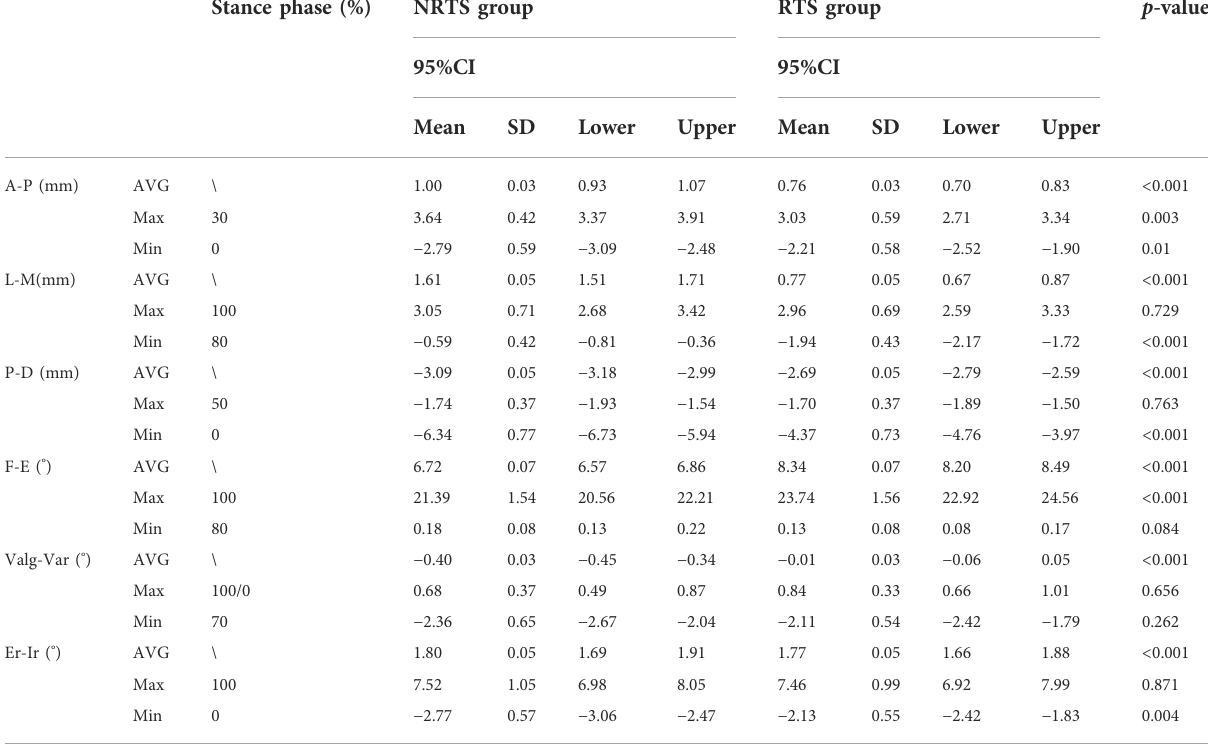
TABLE 2 Comparison of knee kinematics between those who passed the return-to-sports test and those who failed 9 months after ACL reconstruction. a Themaximumvalgus anglewas at100%stance phasein theNRTSgroupwhile0% intheRTSgroup.NRTS,not return-to-sports; RTS, return-to-sports; CI, con fi dence interval; SD,standard deviation; AVG, average value;Max, maximum value; Min, minimum value;A-P, anterior- posterior; L-M, lateral-medial; P-D, proximal-distal; F-E, fl exion-extension; Valg-Var, valgus-varus; Er-Ir, external rotation-internal